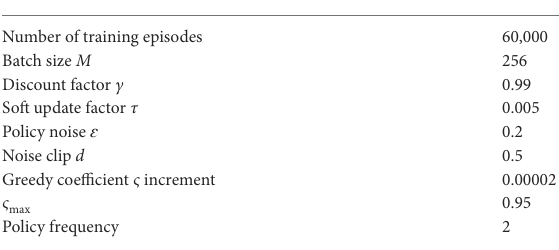
of the critic network is defined as TABLE 2 Training parameters of